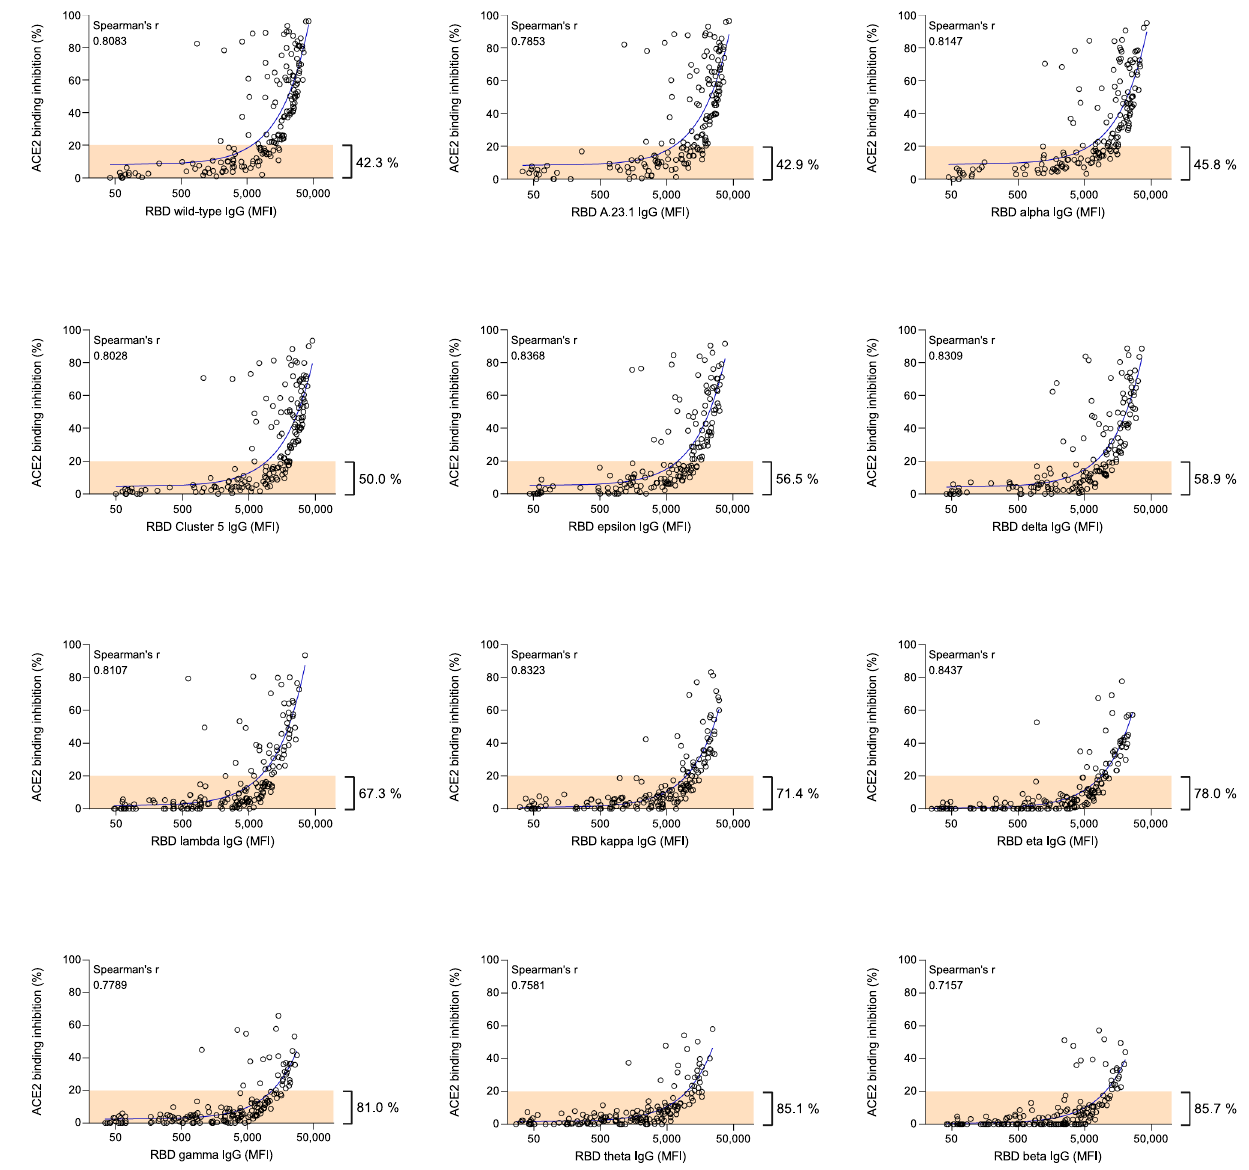
Figure 4. Correlation between anti-RBD IgG MFI signals and ACE2 binding inhibition (%) of serum samples from COVID-19 patients for wild-type and 11 RBD mutants. Regression analysis comparing ACE2 binding inhibition (%) and IgG responses (MFI) for wild-type and all RBD mutants included in the study. Each circle represents one sample (n = 168). For longitudinal donors with more than one sample available, the sample closest to 20 days post positive PCR diagnosis was selected. The percentage next to the bracket indicates the proportion of samples with ACE2 binding inhibition ≤ 20% (in orange). Spearman’s correlation coefficient (r) is specified for every